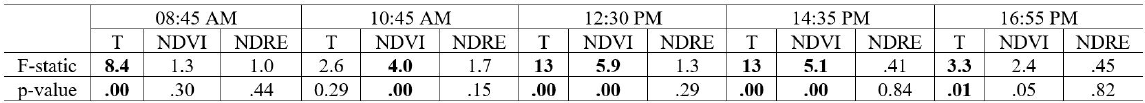
Table 3. ANOVA results of different root depth treatments based on diurnal UAV